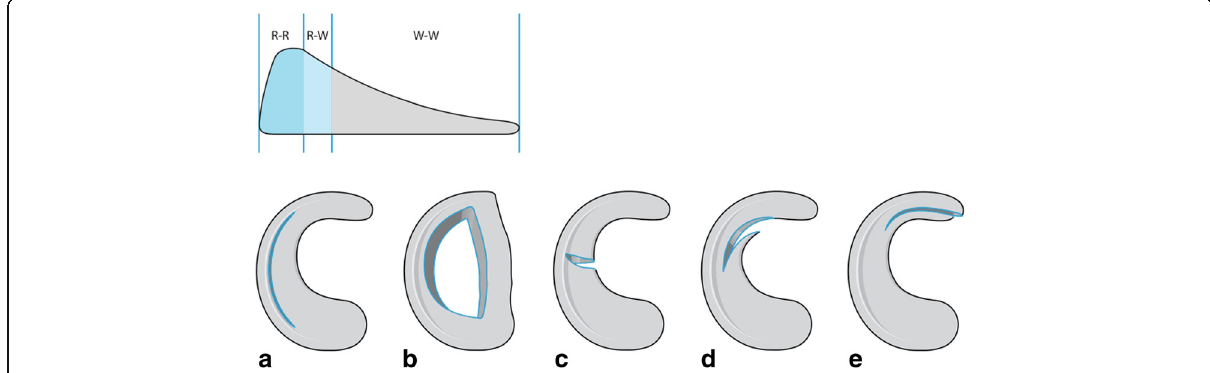
Fig. 1 Schematic drawing: Mensical cross section, different tear types and their suturing potential. R-R: red-red-zone, R-W: red-white zone. W-W: white-white-zone: a longitudinal tear, b bucket handle tear, c radial tear, d flap lesion, e flap lesion with meniscal root participation. Different meniscal tear types: especially large bucket handle tears and radial tears that extend to the meniscal rim should be considered to be